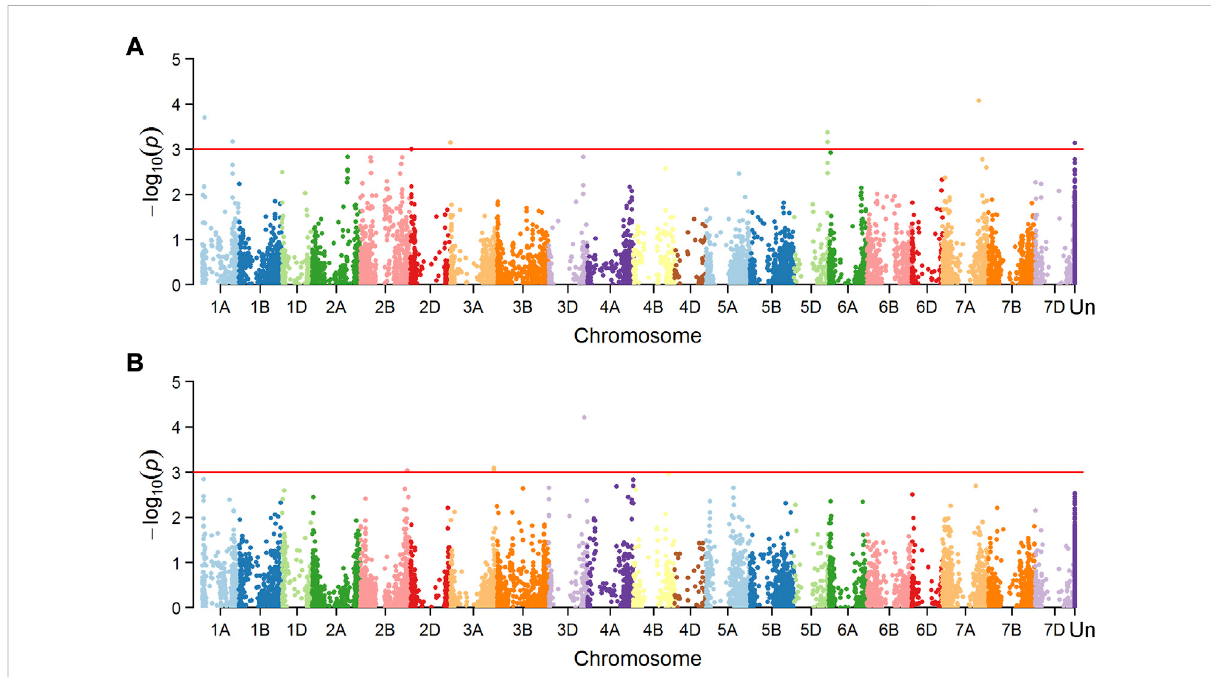
FIGURE 5 Manhattan plots showing SNPs associated with FHB index using spray inoculation (A) and those for DON content (B) using spray inoculation in